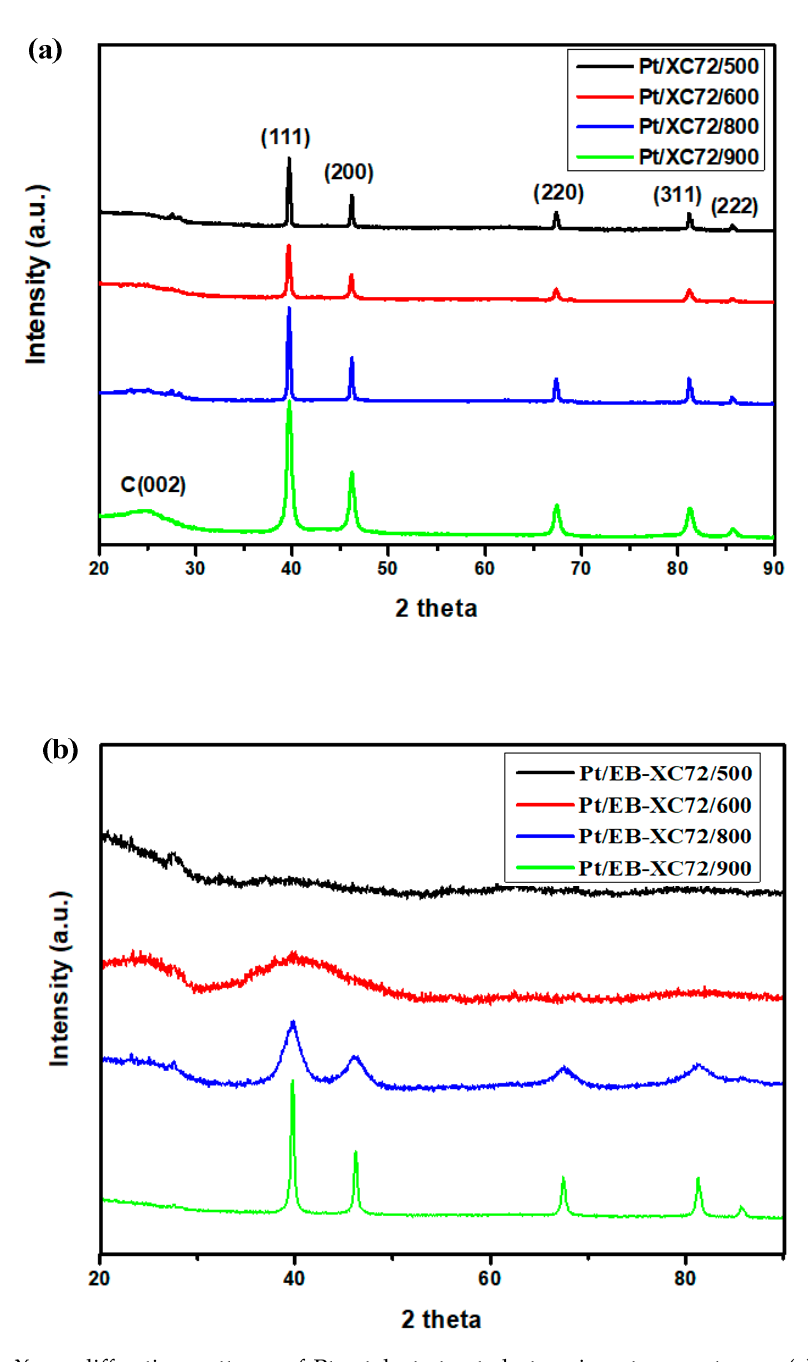
Figure 1. X-ray di ff raction patterns of Pt-catalysts treated at various temperatures. ( a ) Pt / XC72 Figure 1. X-ray diffraction patterns of Pt-catalysts treated at various temperatures. ( a ) Pt/XC72 ( b ) ( b ) Pt / Pt/EB-XC72 Table 1. Mean crystal size a (nm) of Pt loaded on different substrates.